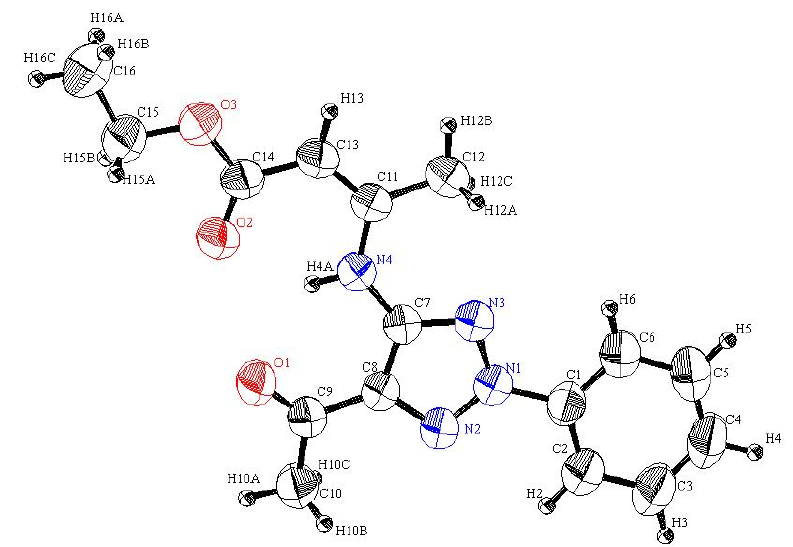
Figure 4. ORTEP plot of the x-ray crystallographic data determined for 23 . Crystallo- graphic data have been deposited in the Cambridge Crystallographic Data Centre as supplementary publication number CCDC 805282 [25].